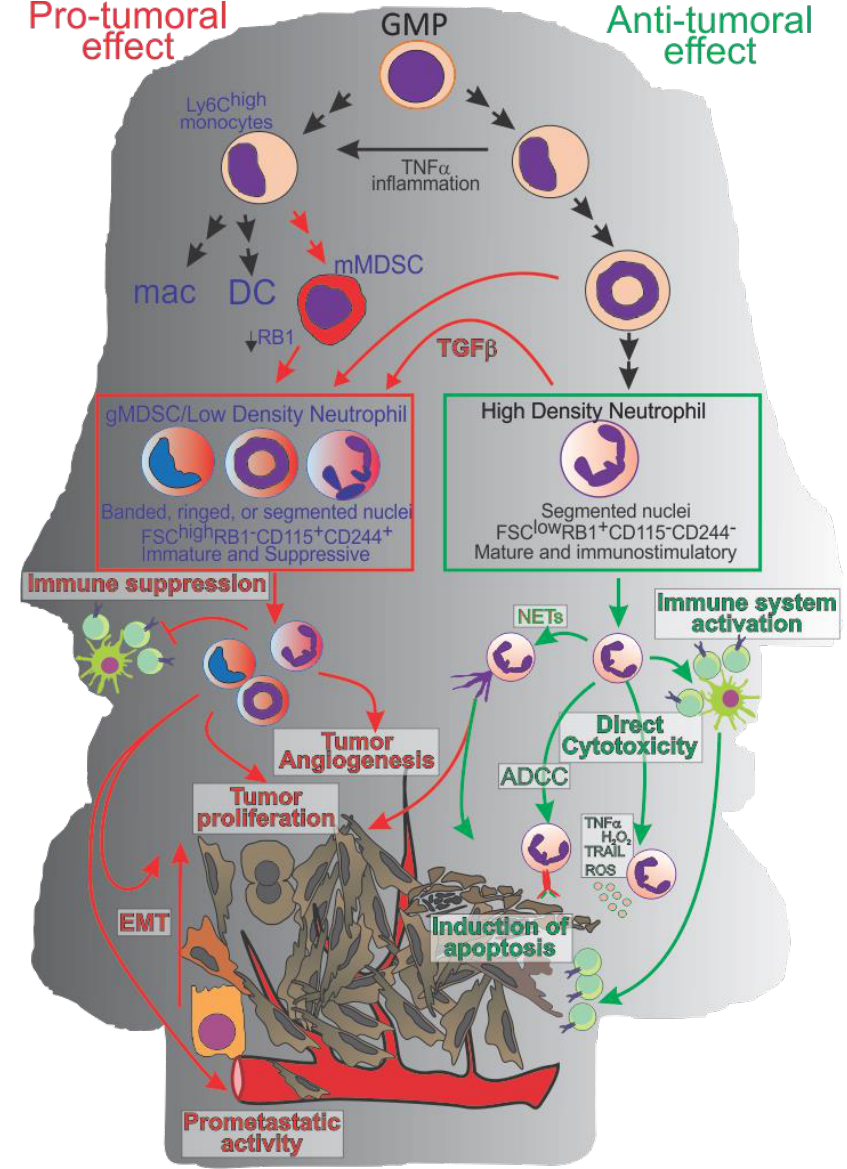
Figure 1. Neutrophil polarization and activity. In physiological conditions or during early stage of tumor progression Granulocyte-Macrophage Progenitor (GMP) cells commit toward mature High Density Neutrophils (HDN) able to exert an anti-tumor activity directly (via ROS, Reactive Nitrogen Species, Tumor Necrosis Factor-α TNF-α; TNF-Related Apoptosis-Inducing Ligand; TRAIL, anti-microbial protein or antibody-dependent cell-mediated cytotoxicity, ADCC) or indirectly by modulating the adaptive immune response. During cancer progression, Tumor Derived Factors (TDFs) modulate neutrophils and myeloid cell polarization toward a pro-tumoral phenotype (gMDSC and or low density neutrophils) characterized by an immature phenotype, by the capacity to inhibit the adaptive immune response, promote tumor angiogenesis, endothelial to mesenchymal transition (EMT), and metastases.